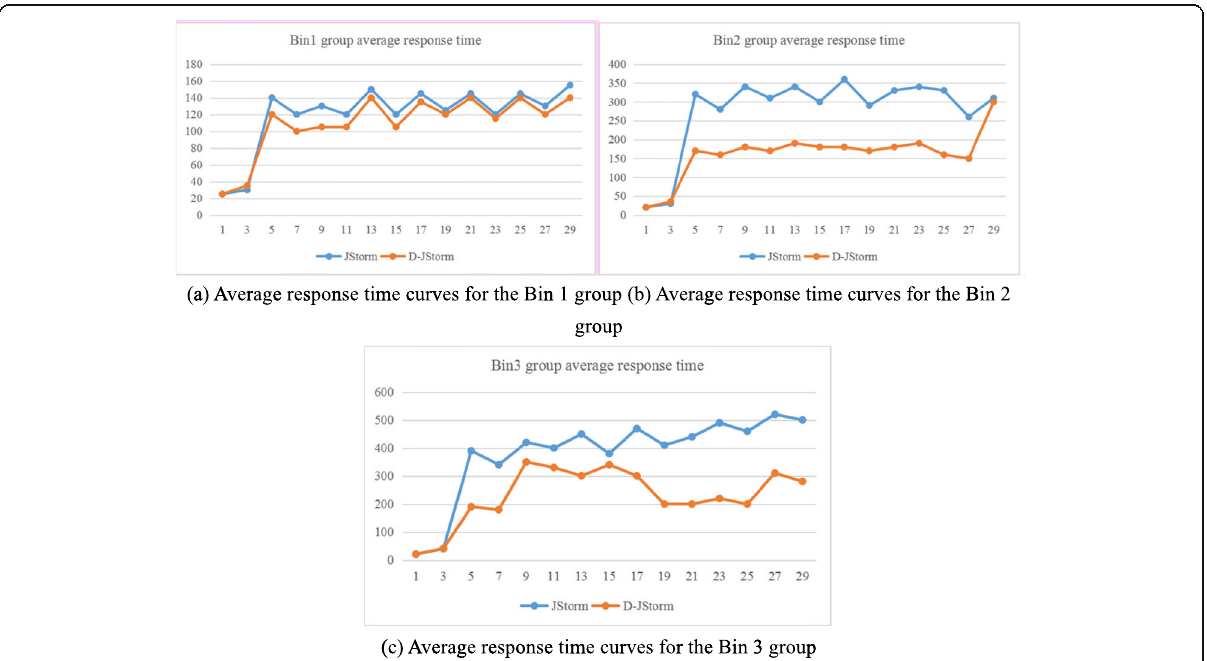
Fig. 2 Comparison of average response time under different data arrival intensities. a Average response time curves for the Bin 1 group. b Average response time curves for the Bin 2 group. c Average response time curves for the Bin 3